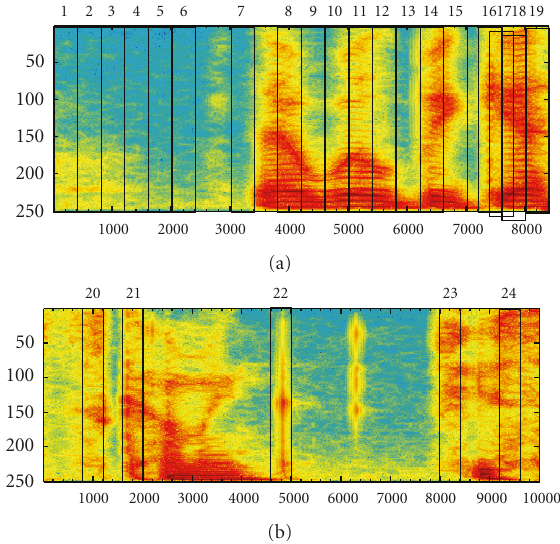
Figure 1: Illustration of various regions within the speech signal.